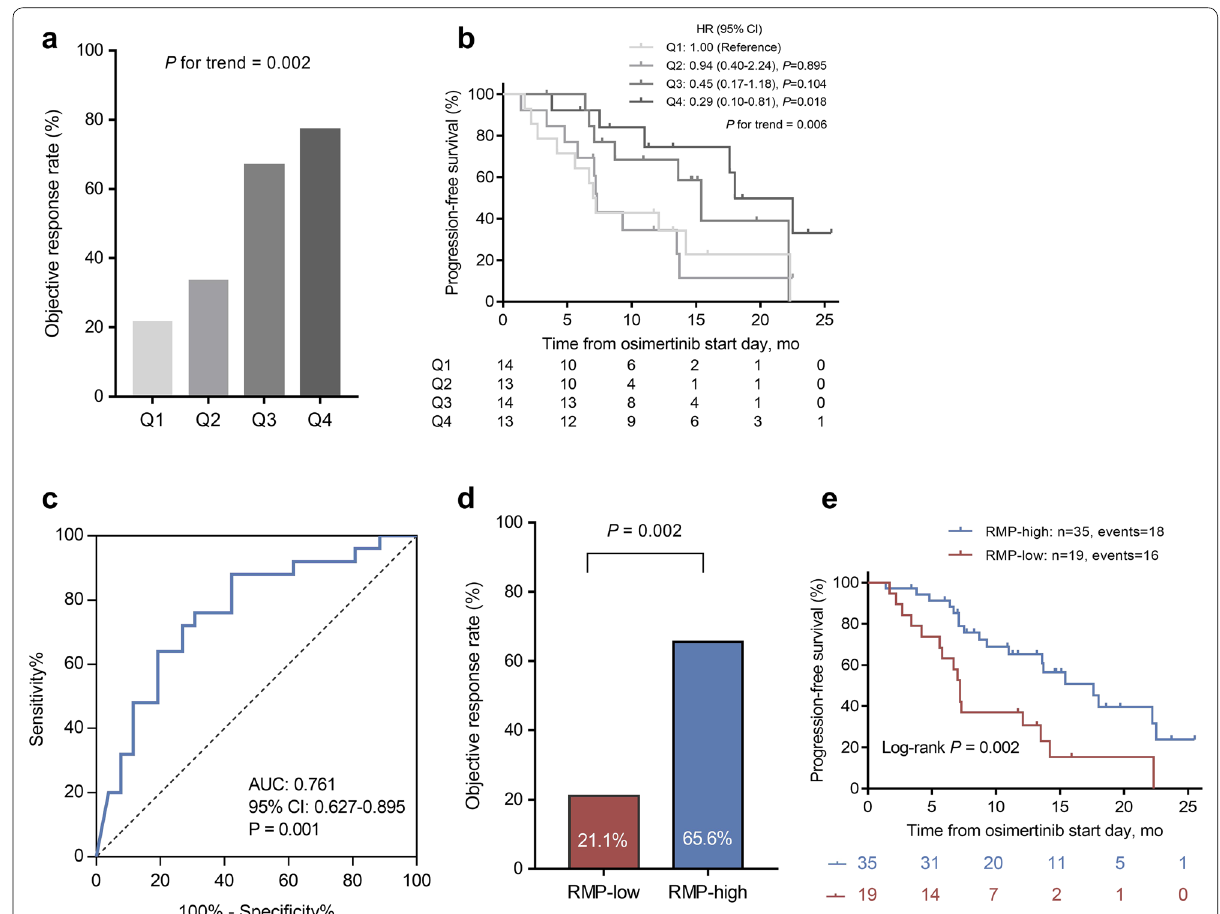
Fig. 4 Correlation between T790M relative mutation purity (RMP) and osimertinib treatment outcomes. a Objective response rate (ORR) stratified by T790M RMP quartiles ( P for trend 0.002). b Progression-free survival (PFS) stratified by T790M RMP quartiles ( P for trend = Operating Characteristic (ROC) Curve and area under ROC curve for T790M RMP predicting objective response. d ORR stratified by RMP-low and RMP-high patients (21.1% vs 65.6%, P 0.002). e PFS stratified by RMP-low and RMP-high patients (P =